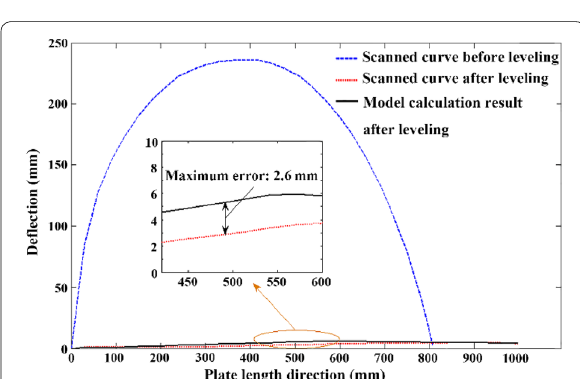
Figure 11 Plate deflection curve